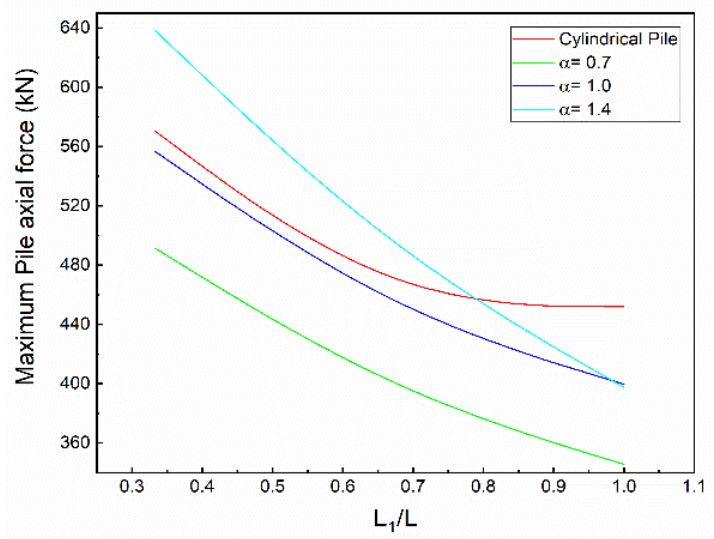
Figure 11. Maximum axial force for different pile shapes.